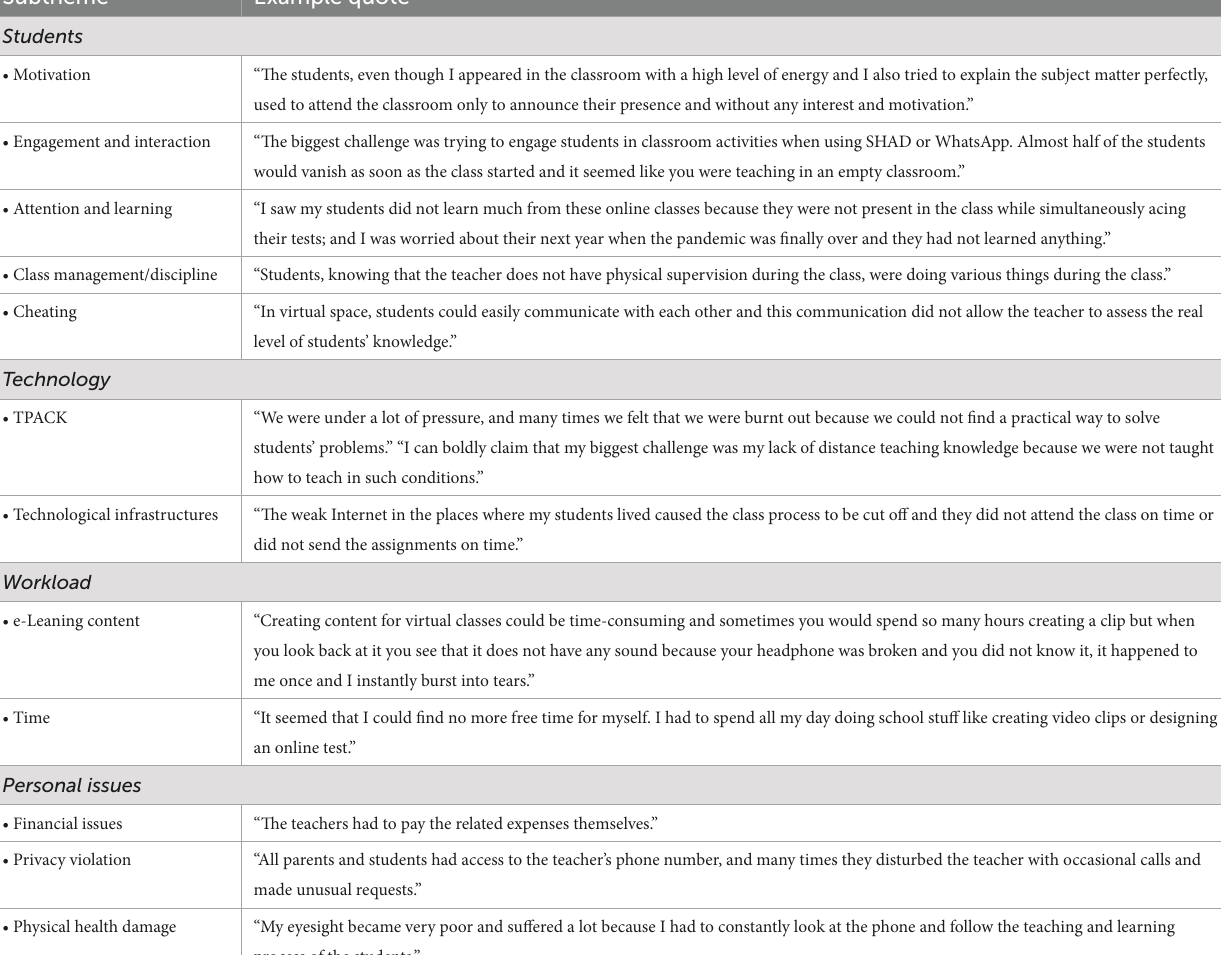
TABLE 8 Theme 1 sources of burnout: Subthemes, categories, and example quotations. Subtheme Example